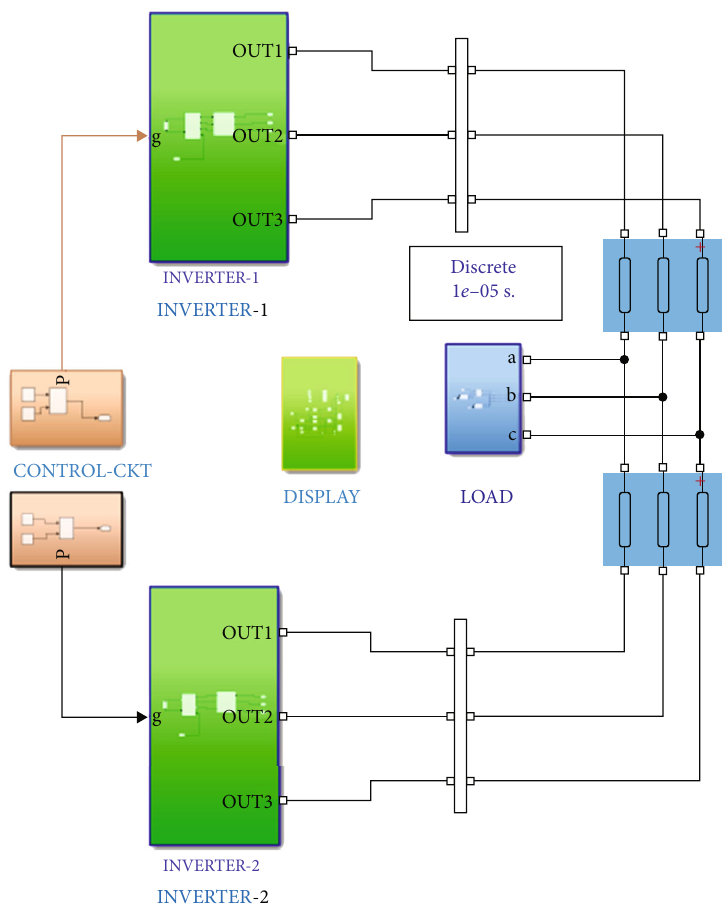
Figure 11: Overall simulation diagram-feature reduced stability